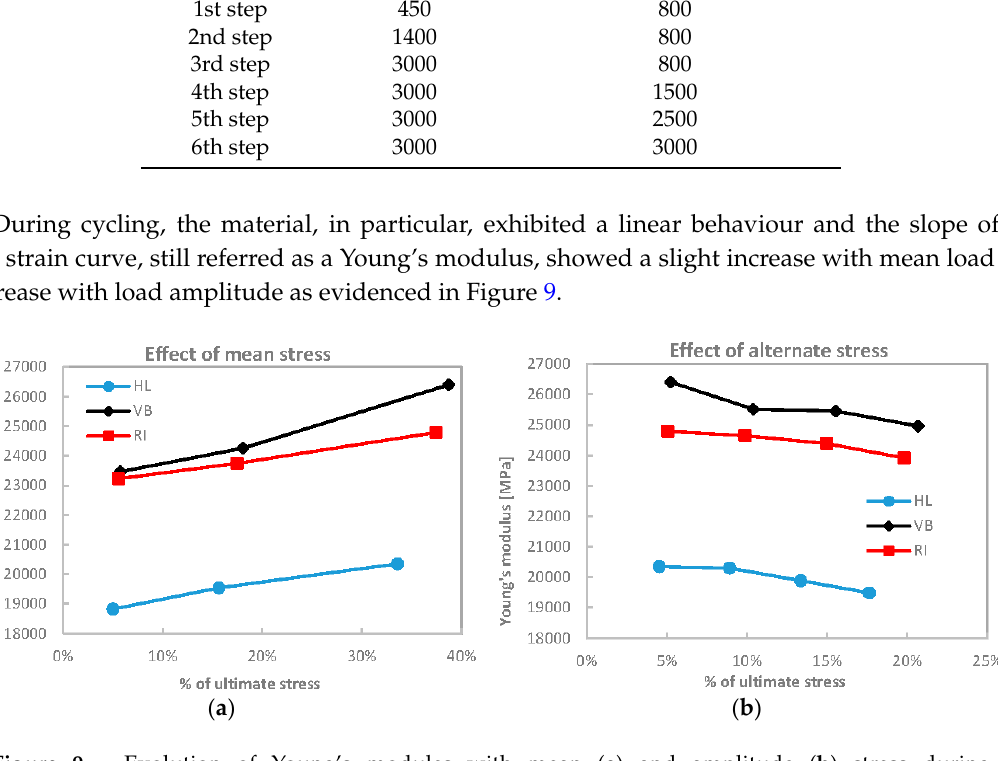
Figure 9. Evolution of Young’s modules with mean ( a ) and amplitude ( b ) stress during cycling loading.